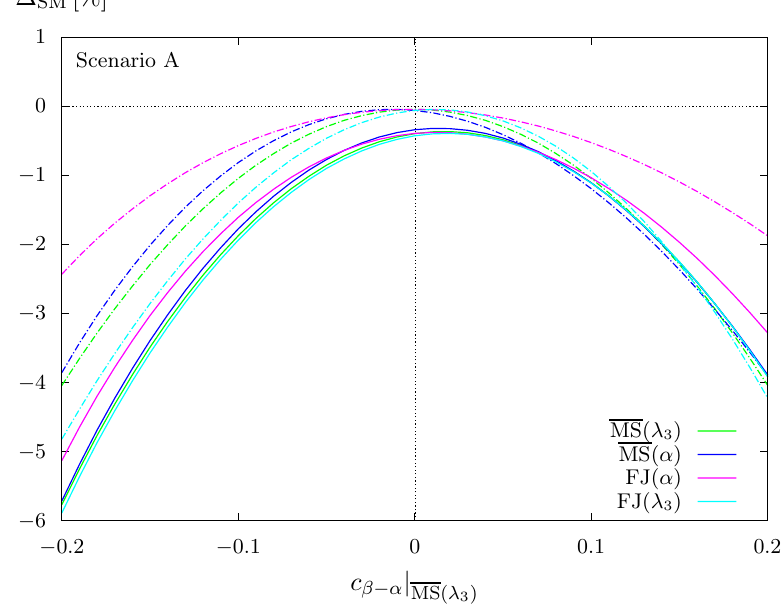
Figure 8 . The relative di(cid:11)erence of the decay width for h 4 f in the THDM w.r.t. the SM ! prediction at LO (dashed) and NLO EW+QCD (solid). The input values are de(cid:12)ned in the MS( (cid:21) 3 ) scheme and are converted to the other schemes at NLO (also for the LO curves). The results computed with di(cid:11)erent renormalization schemes are displayed with the colour code of (cid:12)gure 5. o(cid:11)set of 0 : 5% is visible even in the alignment limit where the diagrams including (cid:0)